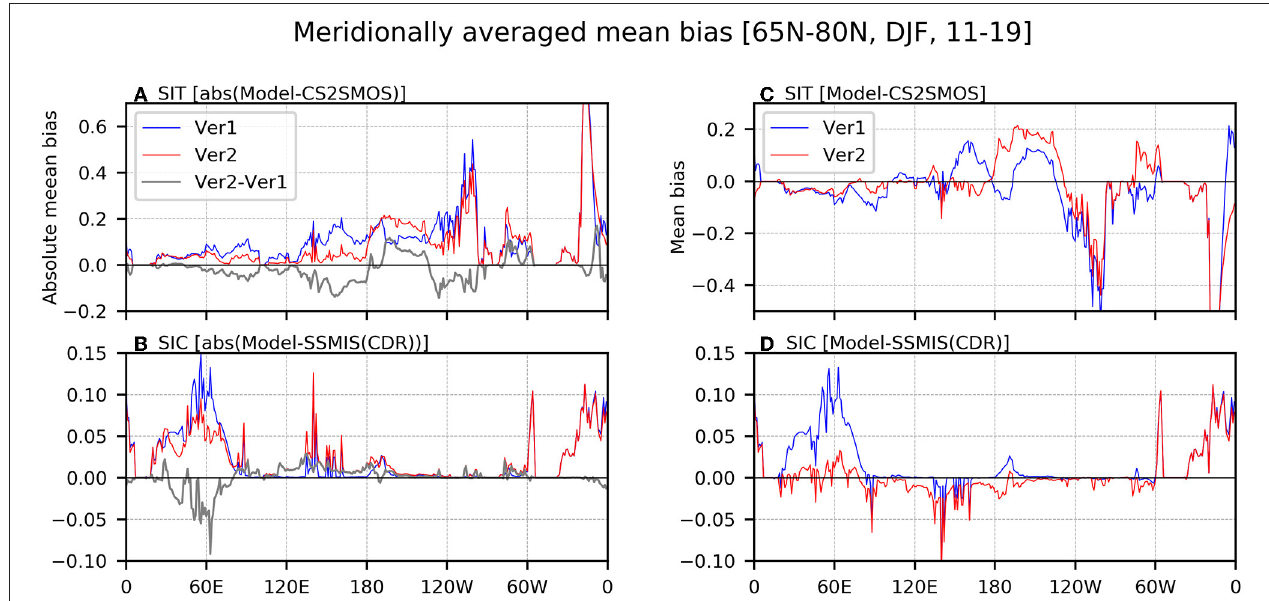
FIGURE 8 | The meridionally averaged (65–80 ◦ N) absolute mean bias (A,B) and mean bias (C,D) between data assimilation experiments (Ver1 represented by blue lines; Ver2 represented by red lines) and satellite observation (CS2SMOS for thickness and SSMIS NT for concentration) for sea ice thickness (m; A,C ) and concentration (a fraction from 0 to 1; B,D ) during DJF season over 2011–2019. The gray lines in left column represent the difference of absolute mean bias between Ver2 and Ver1.